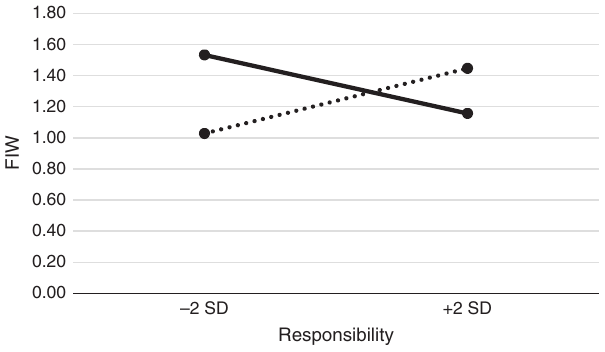
Figure 1. Moderating effect of responsibility on